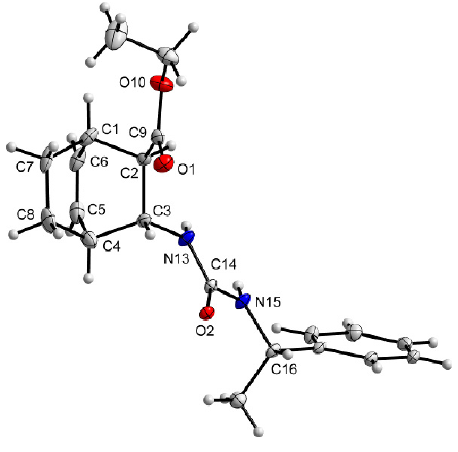
Figure 2. Molecular structure of carbamate (–)- 10 . Thermal ellipsoids have been drawn at the 20% probability